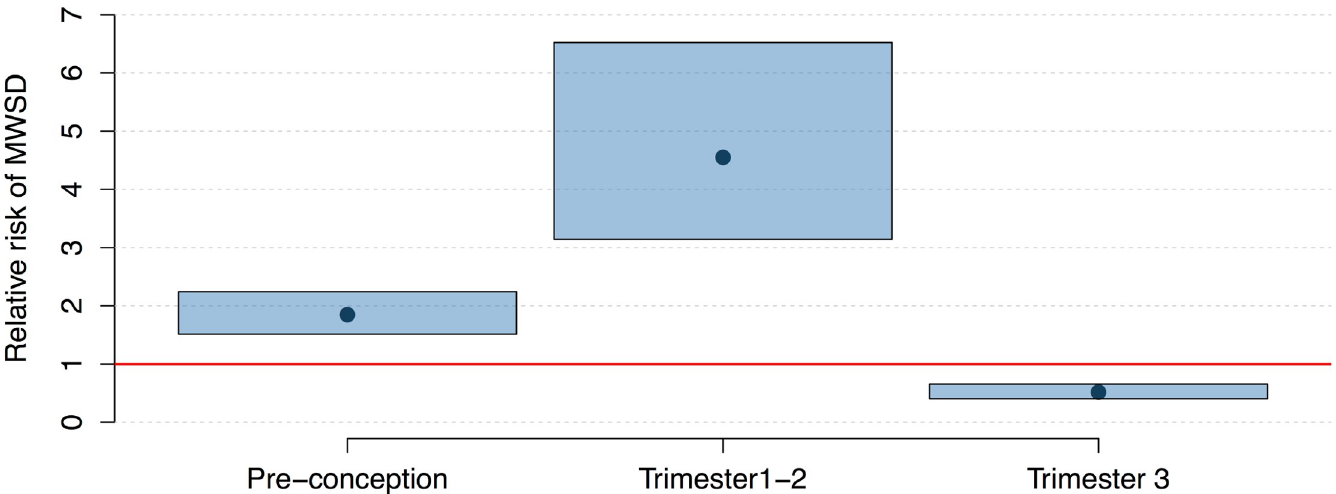
PLOS Medicine| https://doi.org/10.1371/journal.pmed.1002755 March 5,